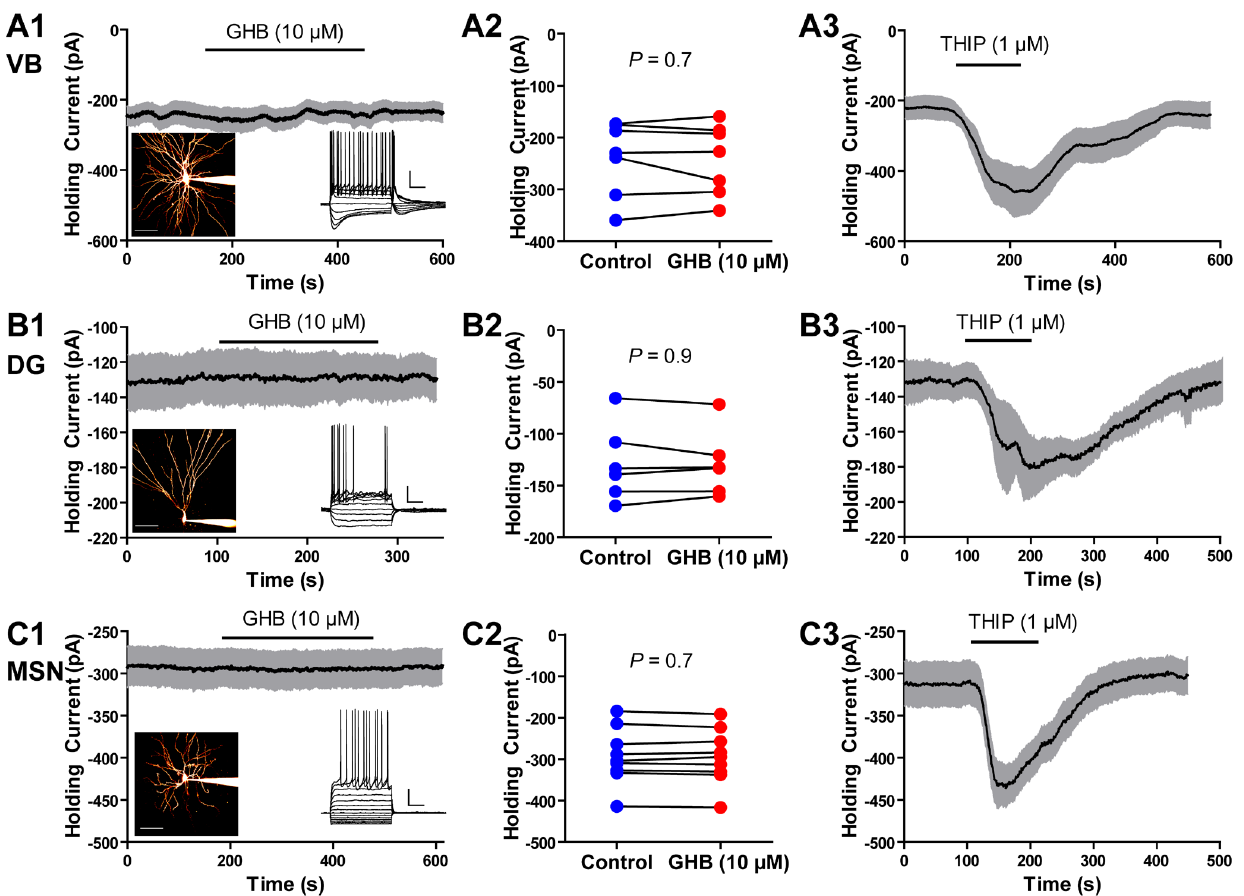
Figure 1. GHB has no effect on the holding current of voltage clamped neurons. A1 , Mean holding current over time in response to the application of GHB in VB thalamic neurons (n=6). Grey area shows SEM. Left inset, representative image of a VB neuron. Scale bar 50 m m. Right inset, voltage response of a representative VB neuron to current injection. Scale bar 20 mV 200 ms. A2 , Group results showing the mean holding current before and after GHB. A3 , The d -selective GABA A agonist THIP induced a significant inward current (control: 2 221 6 33 pA, THIP: 2 508 6 53 pA, n=6, P =0.0007). B1 , Mean holding current over time in response to the application of GHB in dentate gyrus (DG) granule cell (n=6). Grey area shows SEM. Left inset, representative image of a dentate gyrus granule cell. Scale bar 50 m m. Right inset, voltage response of a representative dentate gyrus granule cell to current injection. Scale bar 20 mV 200 ms. B2 , Group results showing the mean holding current before and after GHB. B3 , THIP induced a significant inward current (control: 2 131 6 10 pA THIP: 2 211 6 22 pA, n=7, P =0.01). C1, Mean holding current over time in response to the application of GHB in striatal medium spiny neurons (MSN) (n=9). Grey area shows SEM. Left inset, representative image of a medium spiny neuron. Scale bar 50 m m. Right inset, voltage response of a representative medium spiny neuron to current injection. Scale bar 20 mV 200 ms. C2 , Group results showing the mean holding current before and after GHB. C3 , THIP induced a significant inward current (control: 2 314 6 26 pA THIP: 2 457 6 26 pA, n=10, P , 0.0001).